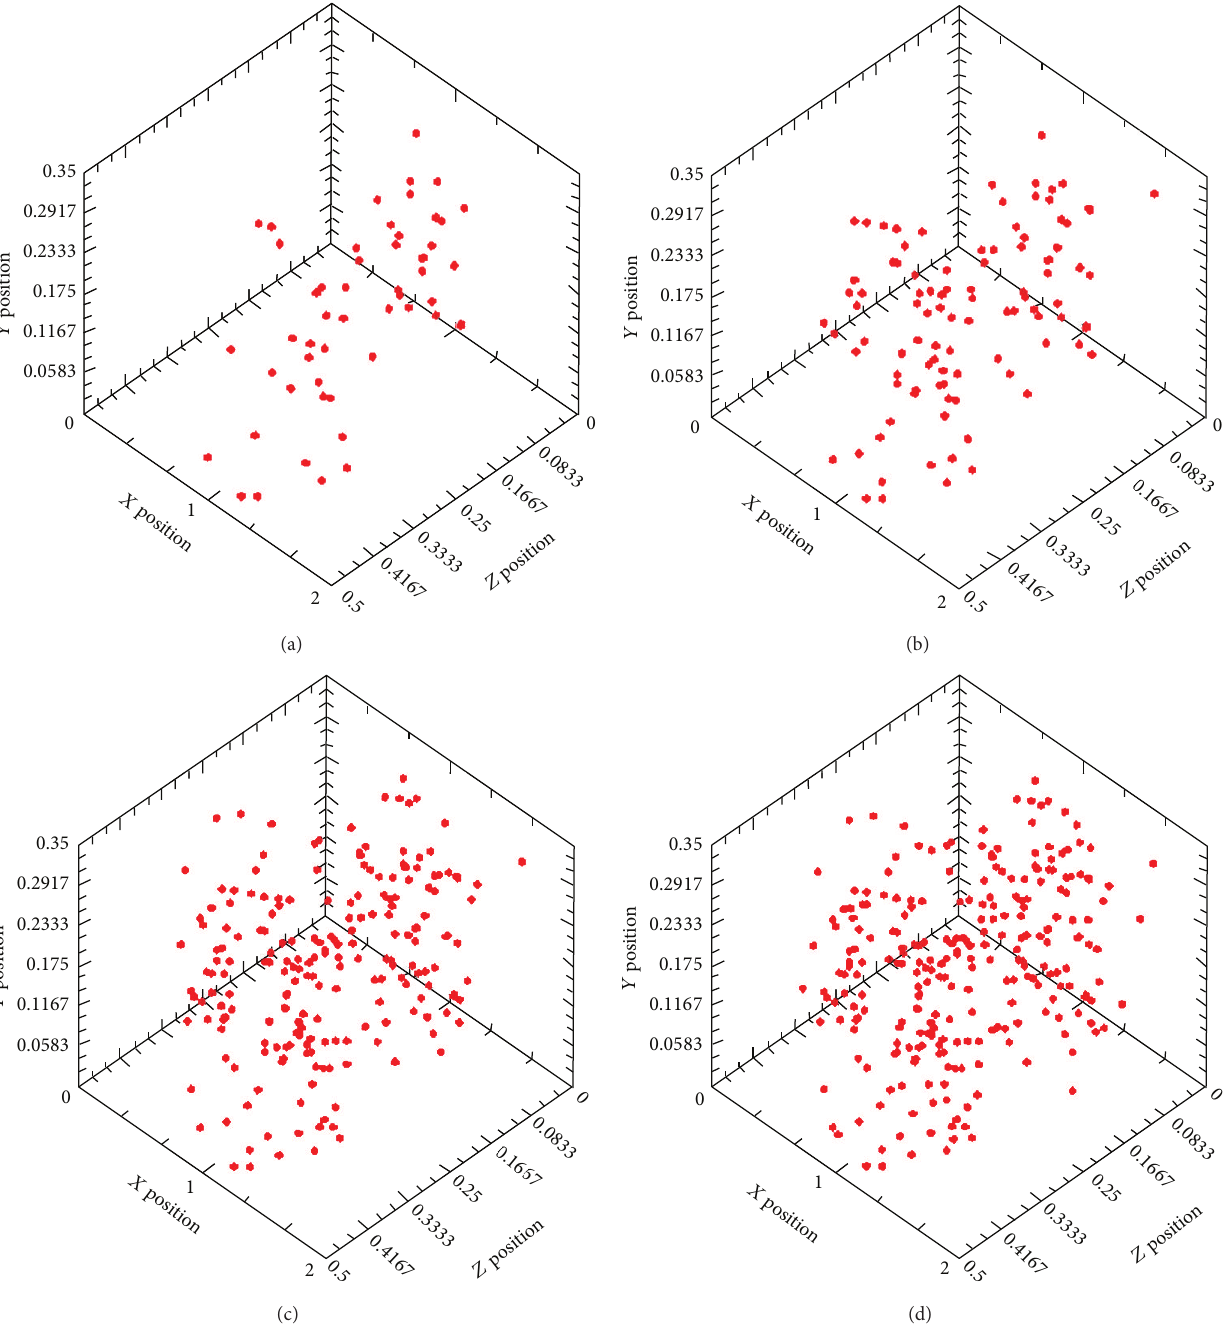
Figure 6: 3D even localization of damage progress with respect to progressive damage evolution. (a) Stage I, (b) stage II, (c) stage III, and (d) stage